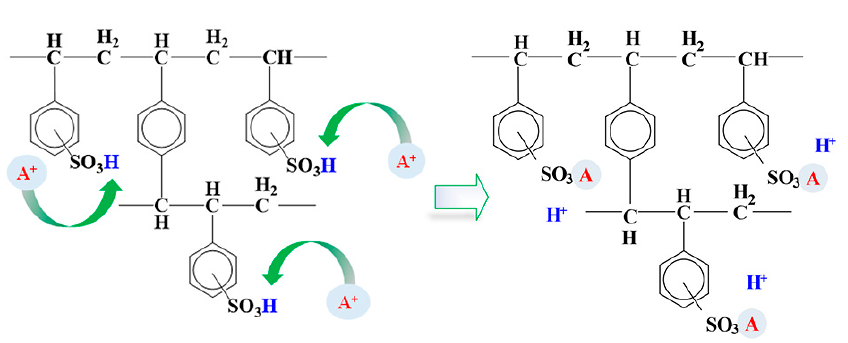
Figure 1. Ion exchange process of cationic part of ionic liquids (represented by A + ) with the H + on ion-exchange resin (Amberlite IR 120Na).